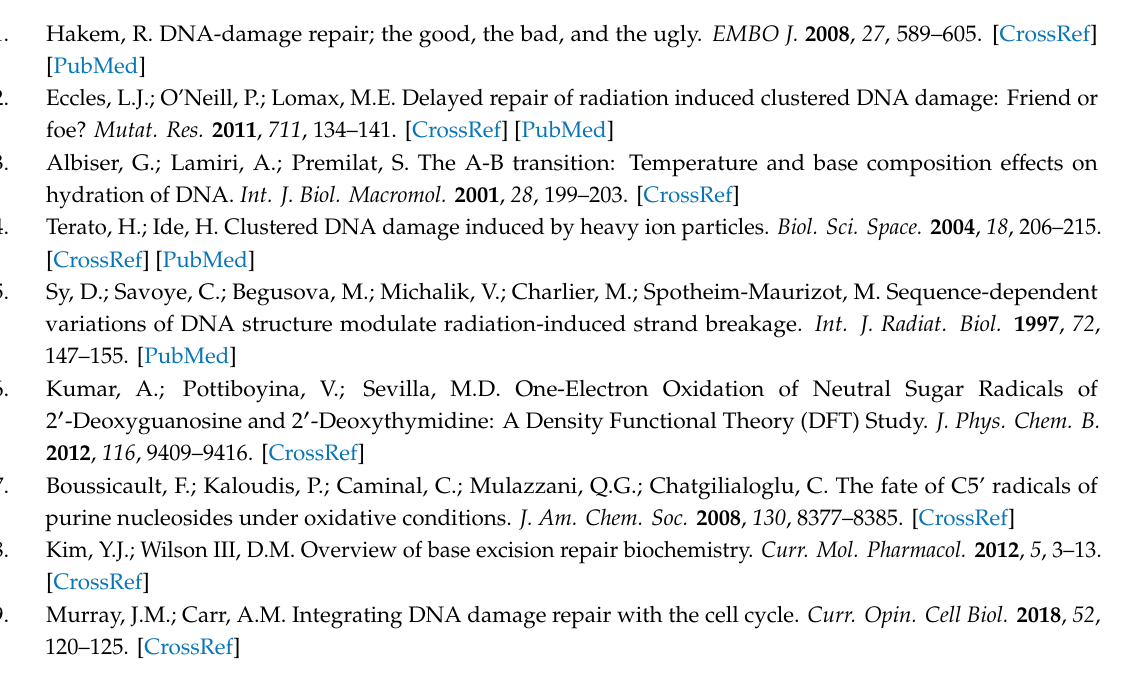
Figure S1: Graphical representation of electron movement during the hole transfer process of the investigated ds -oligonucleotides, Table S1: The energy barriers (in eV) for radical cation migration between base pairs within trimers. Vertical mode, i.e., the energies of each base pair’s radical cation, which were calculated for their neutral geometry. Adiabatic mode i.e., the energies of each base pair’s radical cation were calculated for their cation geometry. Arrows indicate direction of Hole Transfer from one base pair to another e.g., A + → G calculate at the M062X / D95* // M062x / 6-31 + G** level of theory in the aqueous phase, Table S2. The energies (in Hartree) of Neural, Vertical Cation, Adiabatic Cation and Vertical Neutral forms of base pairs extracted from ds -oligonucleotides calculated at the M062x / D95* // M062x / 6-31 + G** level of theory in the aqueous phase, Table S3: The nuclear relaxation energy, energy barrier G, activation energy E a , hole transfer rate constant K HT , and electron coupling energies V da calculated at the M062X / D95* // M062x / 6-31 + G** level of theory in the aqueous phase, Table S4: The Ground and Excitation state energies and Excitation and HOMO energies as well as corresponding Dipole Moments (Ground Excitation and Transition) of base pair dimers extracted from ds -oligonucleotides, calculated at the M062x / D95* // M062x / 6-31 + G** level of theory in the aqueous phase using the DFT or TD-DFT methodology, Table S5 Hirshfeld charge and spin distribution in the shape of ds -oligonucleotides oxo G 2,4 DNA, RcdA oxo G 2,4 DNA, ScdA oxo G 2,4 DNA, only nucleosides bases were taken into consideration, calculated at the M062X / D95* // M062x / 6-31 + G** level of theory in the aqueous phase, Table S6: Base pair Adiabatic (AIP) and Vertical (VIP) Ionisation Potential extracted from ds -oligonucleotides: oxo G 2,4 DNA, RcdA oxo G 2,4 DNA, ScdA oxo G 2,4 DNA, calculated at the M062X / D95* // M062x / 6-31 + G** level of theory in the aqueous phase, Table S7: Energies (in Hartree) of Neutral, Vertical Cation, Adiabatic Cation and Vertical Neutral forms of ds -trimers extracted from ds -oligonucleotides calculated at the M062x / D95* // M062x / 6-31 + G** level of theory in the aqueous phase, Table S8: Root-Mean-Square Deviation of atomic positions (RMSD) in Å, calculated for ds -oligonucleotides in their Neutral and Cationic forms, Table S9: Aromatic ring overlaps (in Å 2 ) of base pair dimers extracted from ds-oligonucleotides. Geometries, optimized at the M062x / D95* level of theory in the aqueous phase, Table S10: Stacking Energy E ST of base pair dimers extracted from ds -oligonucleotides, calculated at the M062x / D95* // M062x / 6-31 + G** level of theory in the aqueous phase